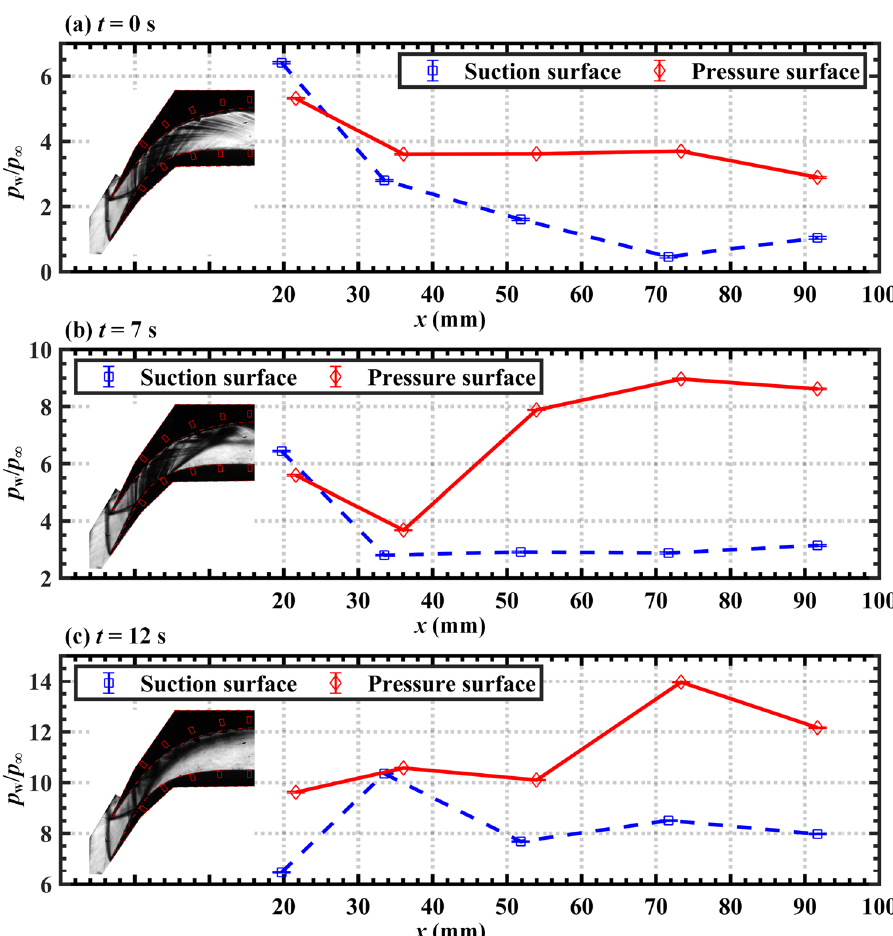
Figure 4. Normalized time-averaged wall pressure distributions along the center line of the supersonic cascade at ( a ) t = 0 s, ( b ) t = 7 s, and ( c ) t = 12 s. The schlieren images of the flow field at the corresponding times are presented on the